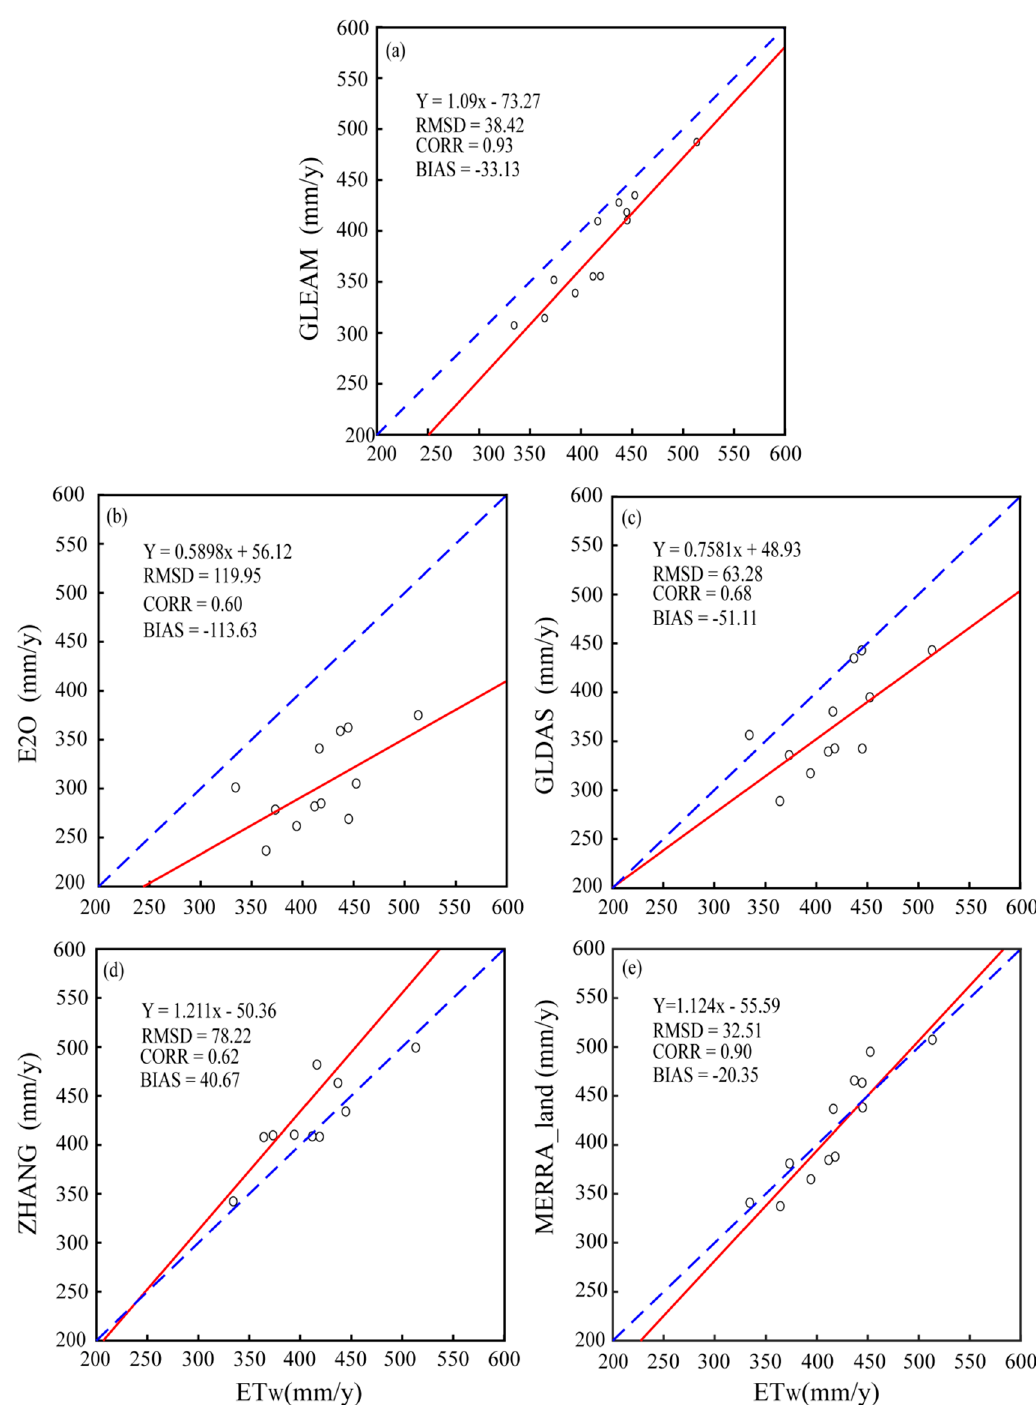
Figure 2. Annual evapotranspiration (ET) amount of (a ) GLEAM, ( b ) E2O, ( c ) GLDAS, ( d ) ZHANG, and ( e ) MERRA_land against water balance ET ( ET w ) across the 12 catchments in the Yangtze River Basin (the red line is the fitted line and the blue line is the line of perfect fit y = x).